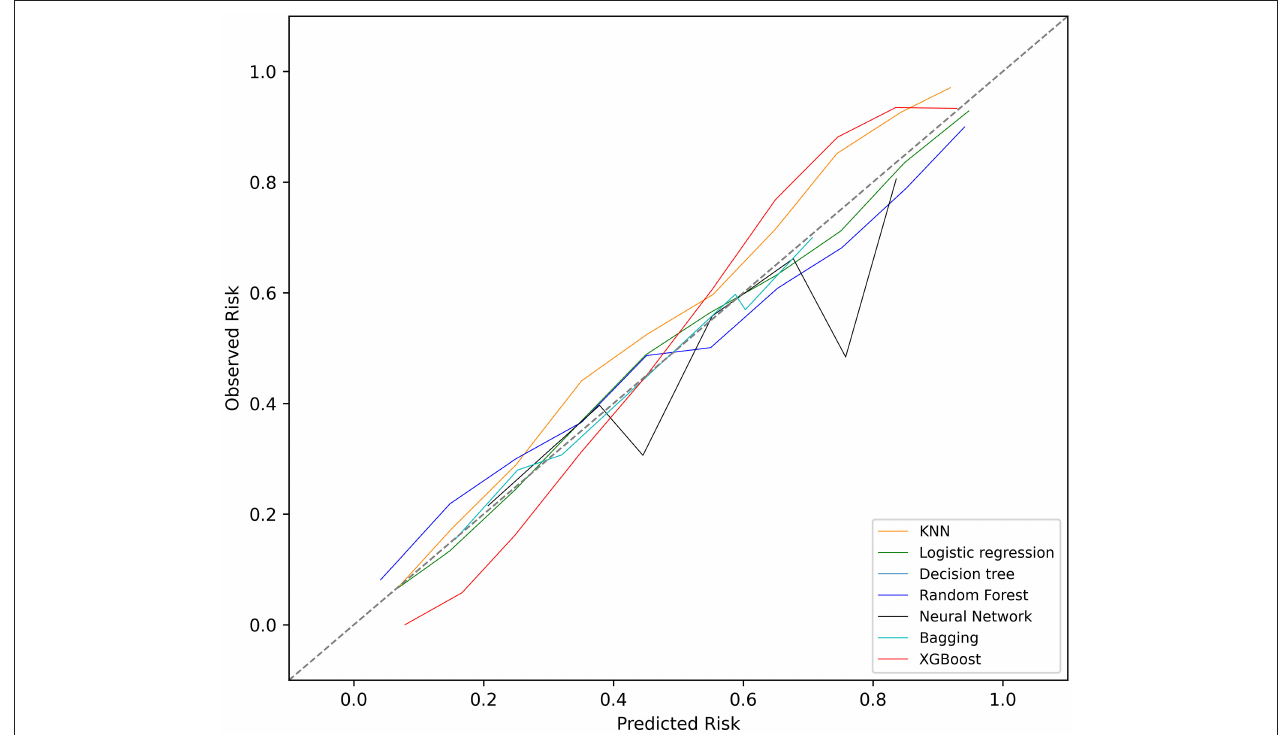
FIGURE 3 | Calibration plots of the seven models. KNN, k-nearest neighbors; XGBoost, Extreme Gradient Boosting.